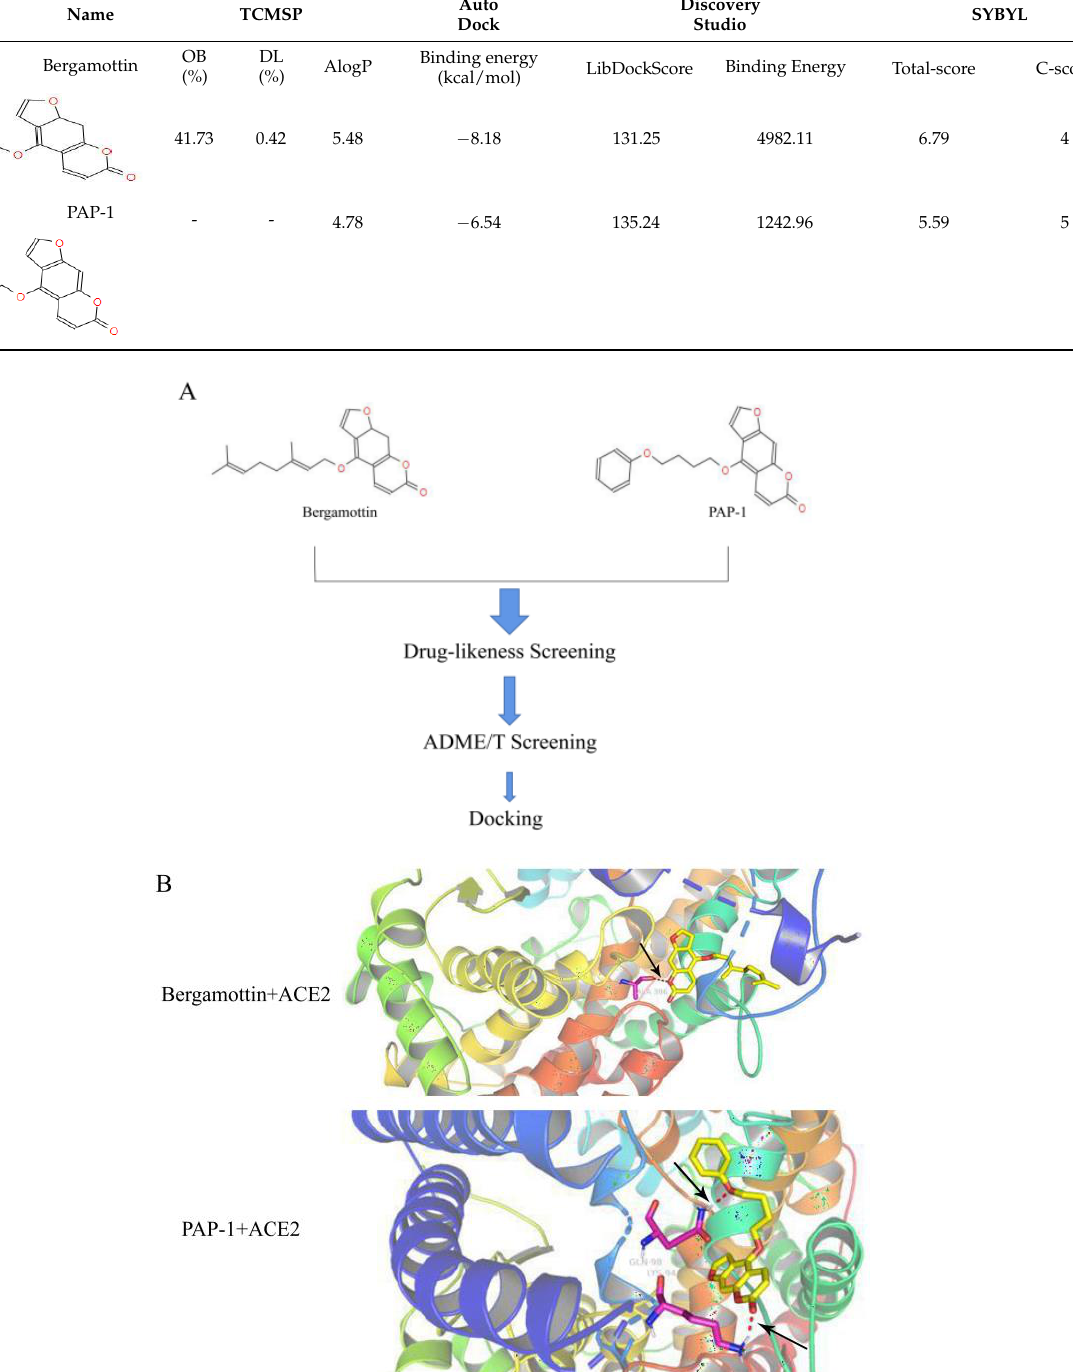
Figure 1. ( A ) Chemical structures of bergamottin and PAP-1. ( B ) Bergamottins and PAP-1 via utodocking tools to predict the binding of the analogue molecules with ACE2 docking pose.